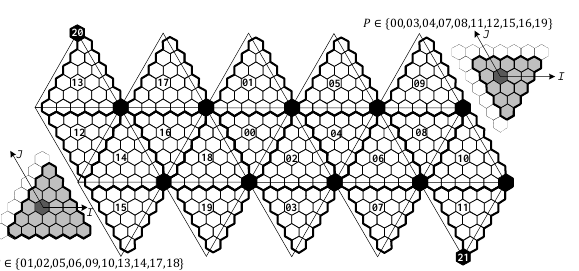
Figure 1. Arrangement Pattern of the A4HCI Grid on the Icosahedron, Subdivision n =3.